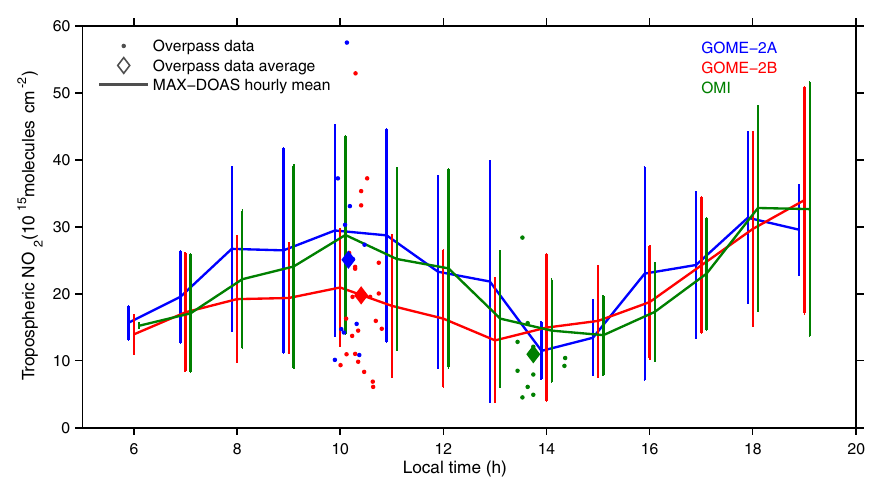
Figure 6. Average diurnal variation of tropospheric NO 2 columns derived from the MAX-DOAS observations at elevation angles of 15 and 30 ◦ in Guangzhou from April 2015 to March 2016. The three lines correspond to the MAX-DOAS hourly mean values resulting only from days with collocated OMI (green), GOME-2A (blue) and GOME-2B (red) data. The error bars indicate the standard deviation of the hourly averages ( ± 1 σ) . The filled circles represent the NO 2 overpass data of the three satellite sensors that are included in the comparison with the MAX-DOAS measurements and the filed diamonds their average. The symbols are color-coded similarly to diurnals; blue, red and green indicate GOME-2A, GOME-2B and OMI overpass data,